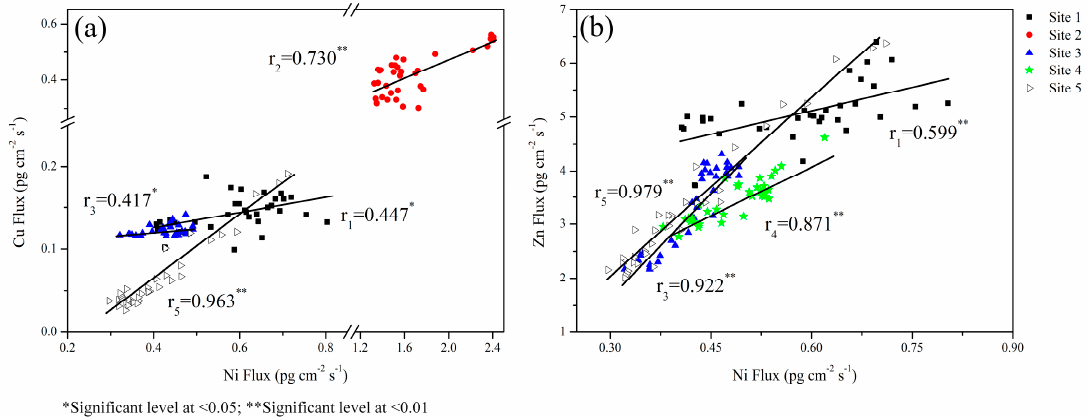
Figure 7. Correlation analyses of labile Ni with labile Cu ( a ) and labile Zn ( b ) in sediments.